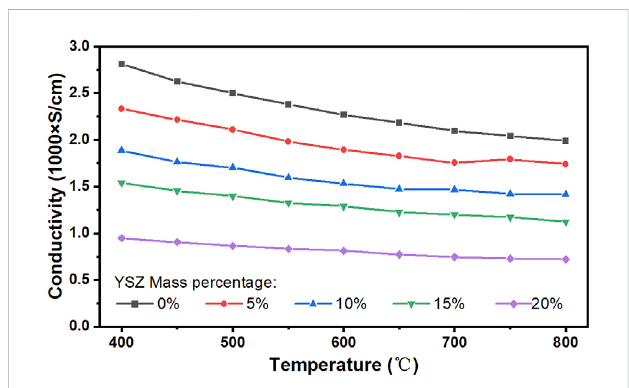
FIGURE 8 Measured electrical conductivity of the SS430L/YSZ metal support (without the addition of pore-formers). The weight percentages of YSZ are based on SS430L.